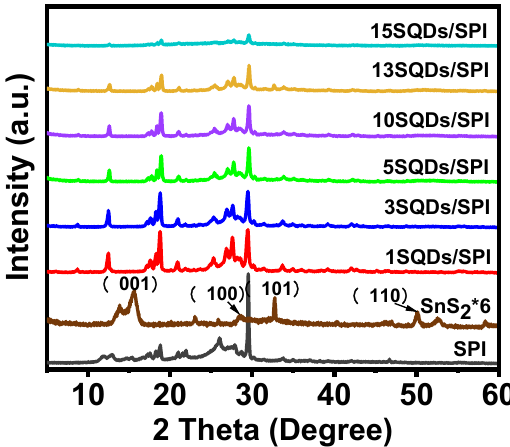
Figure 1. XRD patterns of the SPI, SQDs, and SQDs/SPI composites samples. The diffraction peaks of SQDs located at 2 θ = 15.6°, 28.5°, 32.7°, and 50.1° can be in ‐ dexed to (001), (100), (101), and (110) planes (JCPDS No. 23–677) [38]. These Crystal planes